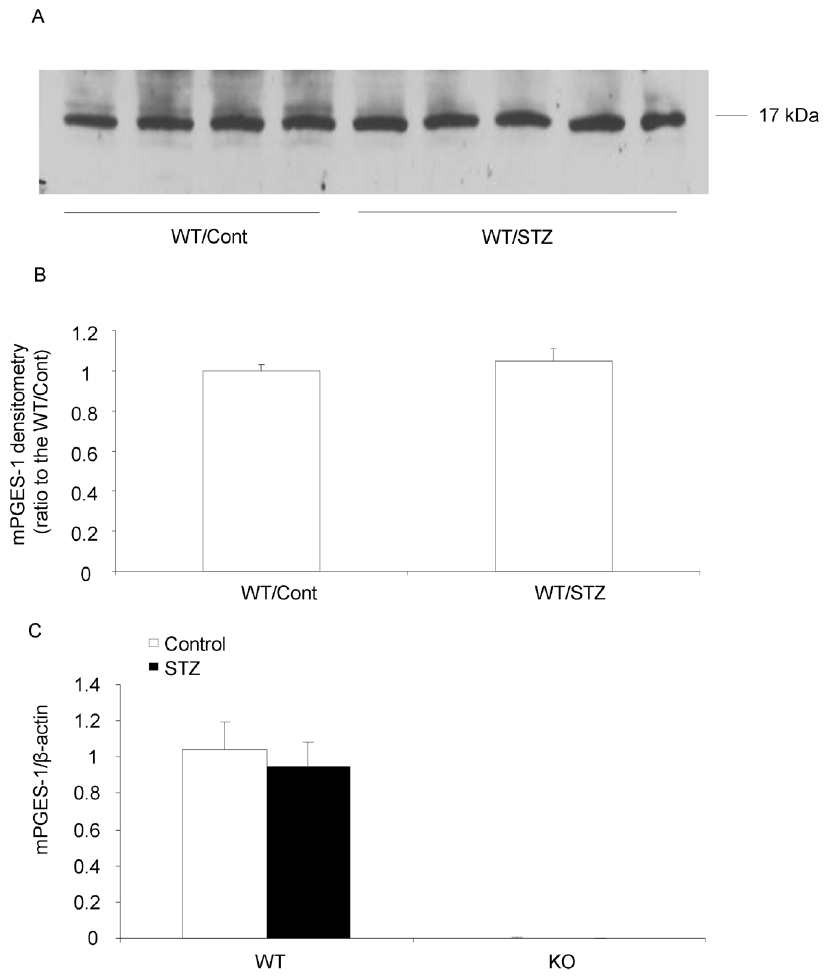
Figure 4. Expressions of mPGES-1 protein and mRNA in diabetic mice. (A) mPGES-1 protein analysis by Western blotting (n=4–5 in each group). (B) Densitometry analysis of mPGES-1 Western blotting. (C) mPGES-1 mRNA expression by qRT-PCR (N=6–9 per group). Data are mean 6